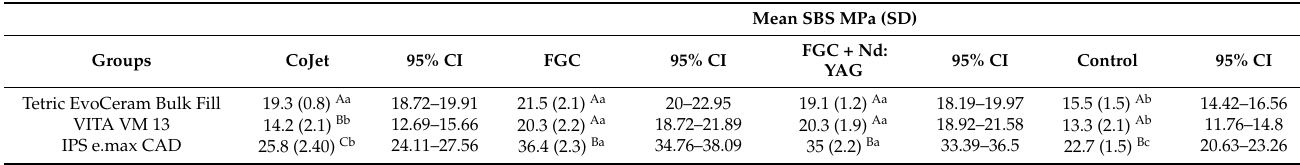
Table 2. Descriptive statistics and Tukey post hoc test of the mean shear bond strength in MPa (SD) and 95% confidence interval (CI) bound of different repair materials to zirconia according to different surface